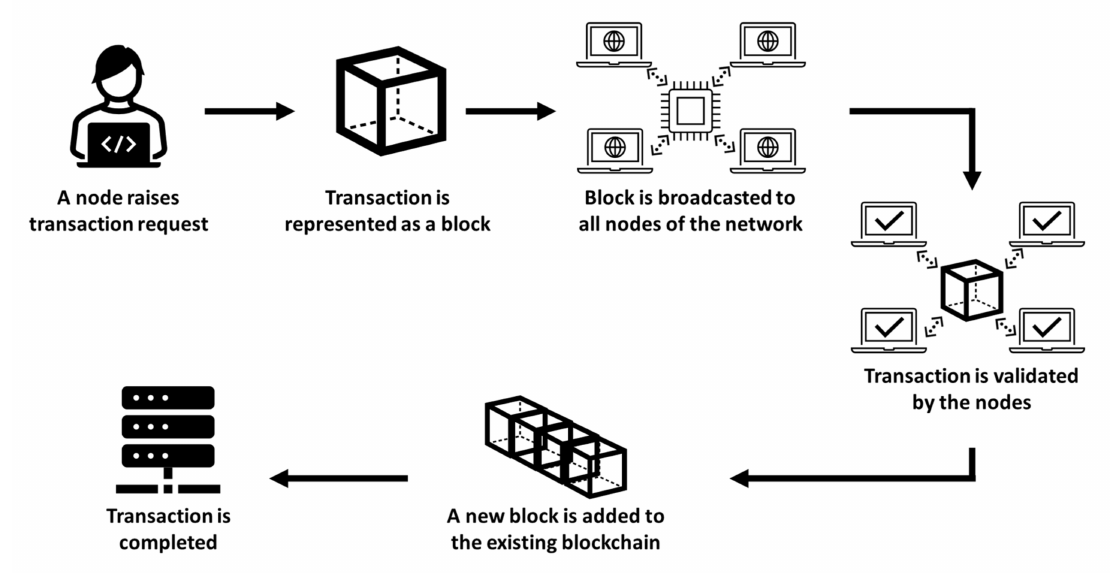
Figure 1. Transaction flow in a blockchain